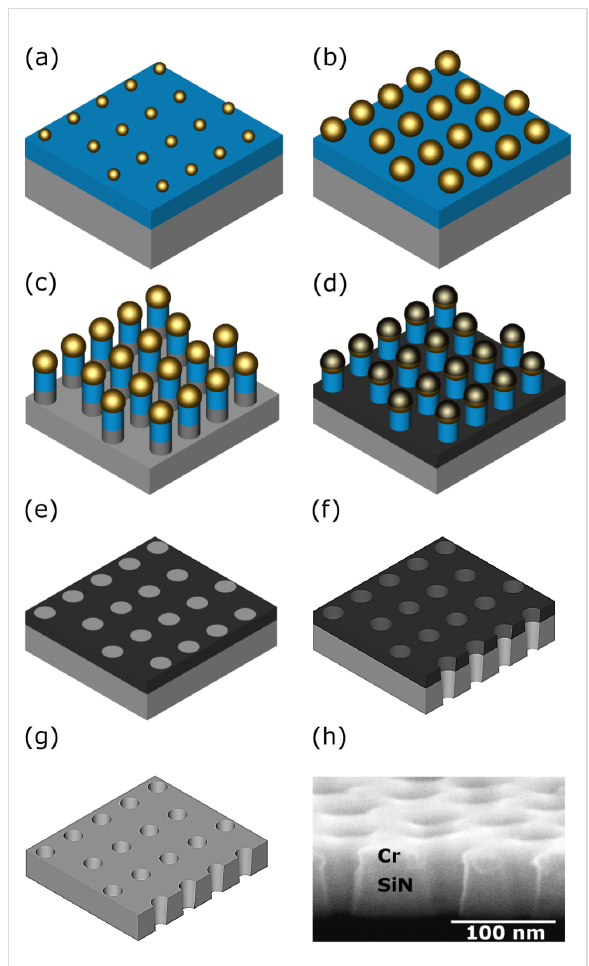
Figure 1: Fabrication scheme for nanoporous membranes: (a) The commercially available silicon nitride membrane (grey) is coated with a sacrificial layer of silicon oxide (blue) on top of which a quasi-hexago- nally ordered array of Au NPs (yellow) is deposited by self-organiza- tion of Au-loaded diblock copolymer micelles followed by plasma treat- ments. (b) Applying a photochemical growth process the Au NP size can be enlarged in a controlled way. (c) The resulting NP mask is exploited to etch nanopillars by RIE, (d) a Cr layer (black) is evaporat- ed, (e) and the pillars are removed by grazing incidence sputtering with Ar ions. (f) Subsequent RIE results in nanopores. (g) Optional removal of the residual Cr layer with a liquid etchant. (h) Experiment: SEM micrograph of the cross-section of membrane A (cf. text) with